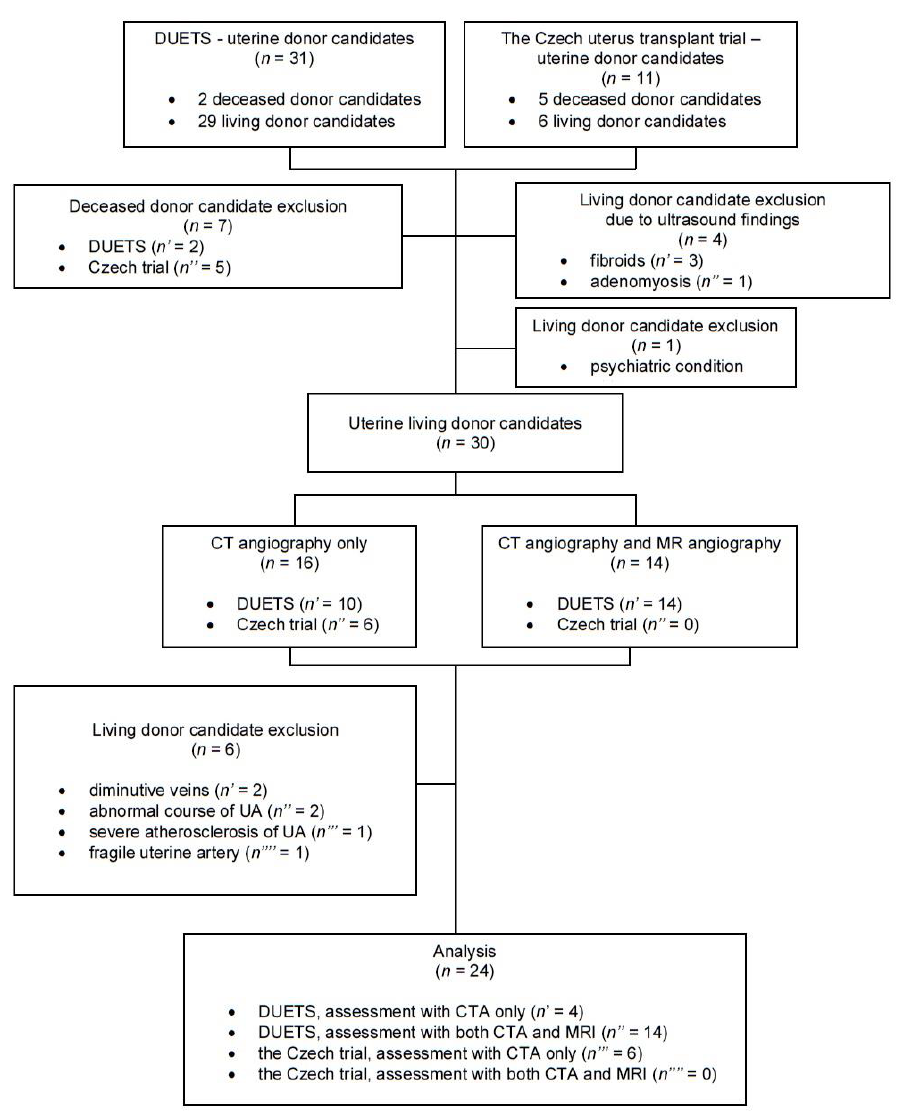
Figure 1. A flow chart depicting the inclusion and exclusion of living donor candidates into the study.